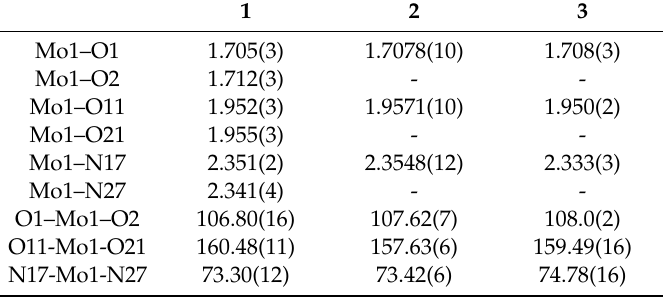
Table 1. Selected bond lengths (Å) and angles ( ◦ ) for the dioxidomolybdenum(VI) complexes 1 – 3